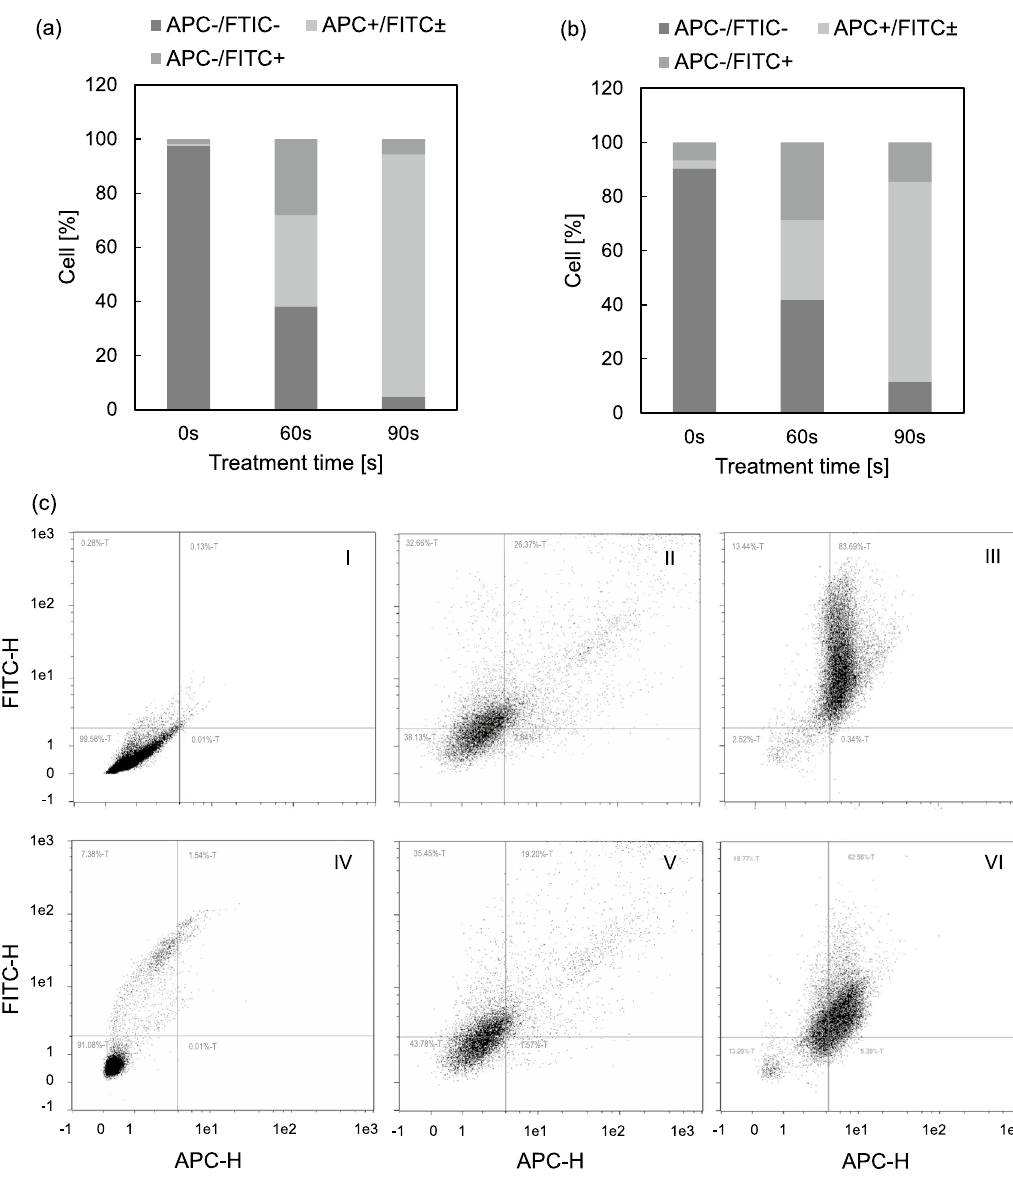
Figure 5. Analysis of apoptosis and necrosis induced by plasma in leukaemia cells in vitro. ( a ) Jurkat cells and − ( b ) U937 cells were assessed at 4-h after treatment with ns-DND plasma. Data represent mean percentage (%) of live (APC-/FITC-), apoptotic (APC+/FITC±) and necrotic cells (APC-/FITC+), n = 3. Compared to untreated cells (0 exposure), significant percentages of apoptotic and/or necrotic cells exist in plasma treated cells vs control cells ( p < 0.05 , n = 3). ( c ) Representative dot plots of apoptosis and necrosis results using APC (Apopxin labelling phosphatidylserine, red fluorescence) vs FITC (Nuclear green DCS1 labelling the nucleus of damaged cells, green fluorescence). I–III, Jurkat cells treated with plasma for 0, 60, 90 s respectively; IV–VI, U937 cells treated with plasma for 0, 60, and 90 s,